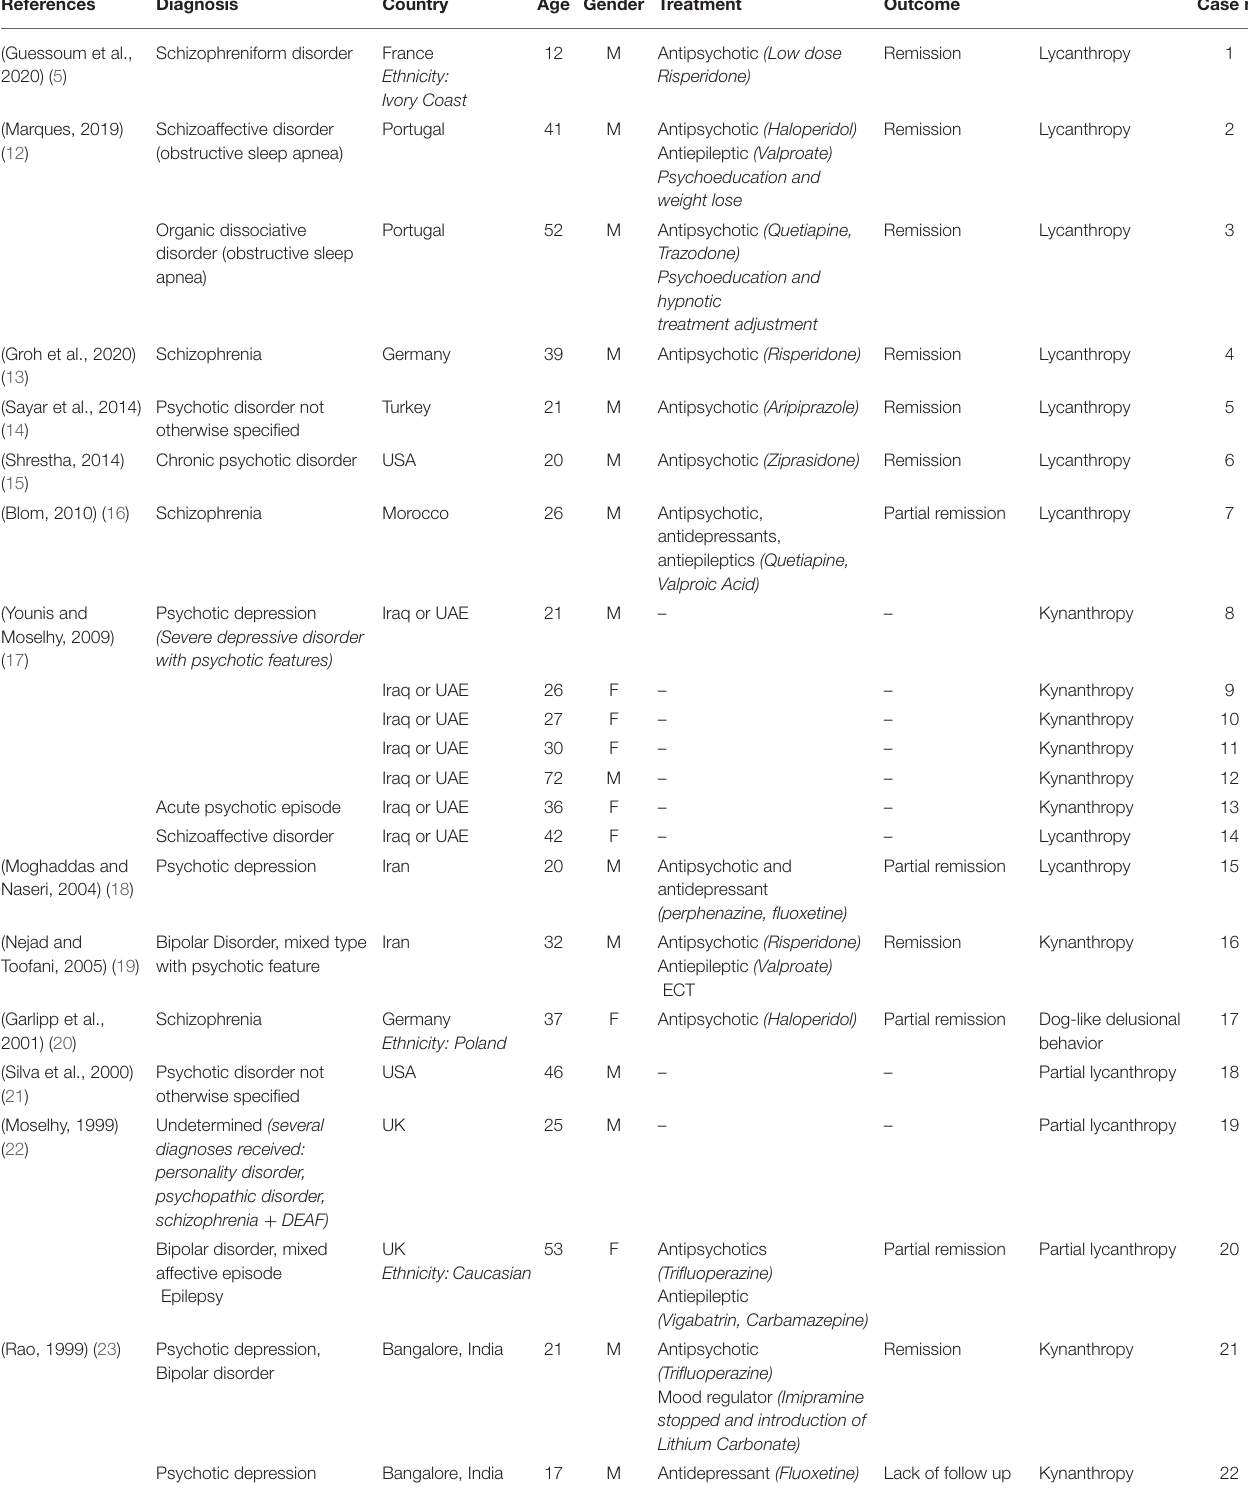
TABLE 1 | Case reports of clinical lycanthropy and